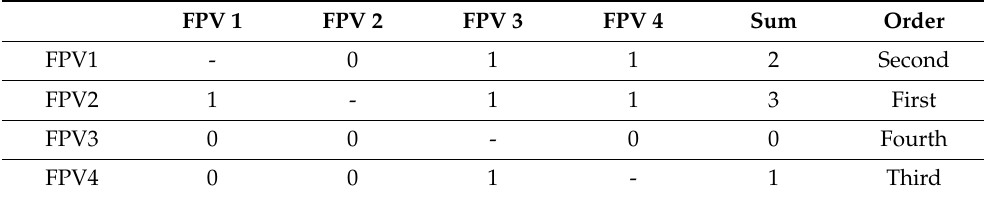
Table 6. Roberts matrix—ordering of FPVs.